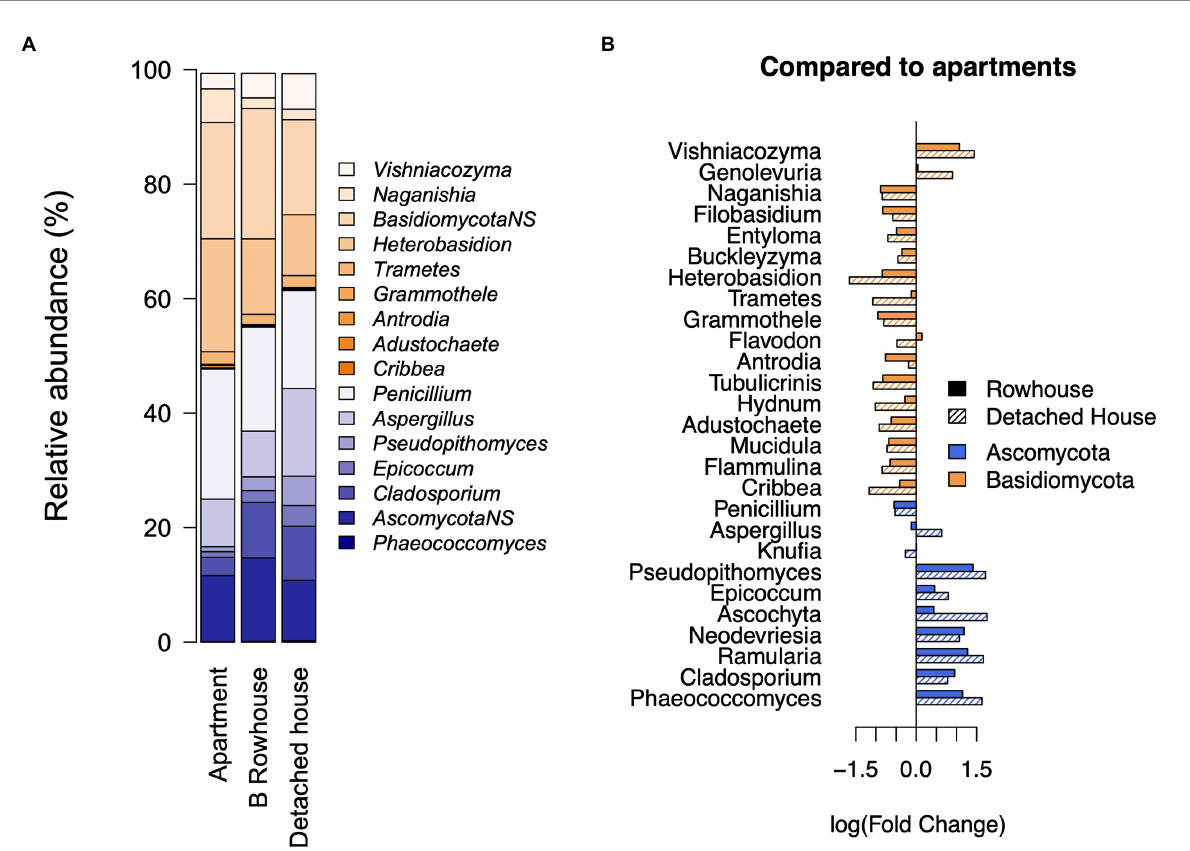
FIGURE 4 Role of the type of home on fungal community. (A) Mean relative abundance of significantly and non-significantly (NS, p>0.06) associated genera by type of home. Effect on genera when (B) compared to apartment buildings with rowhouses, and detached